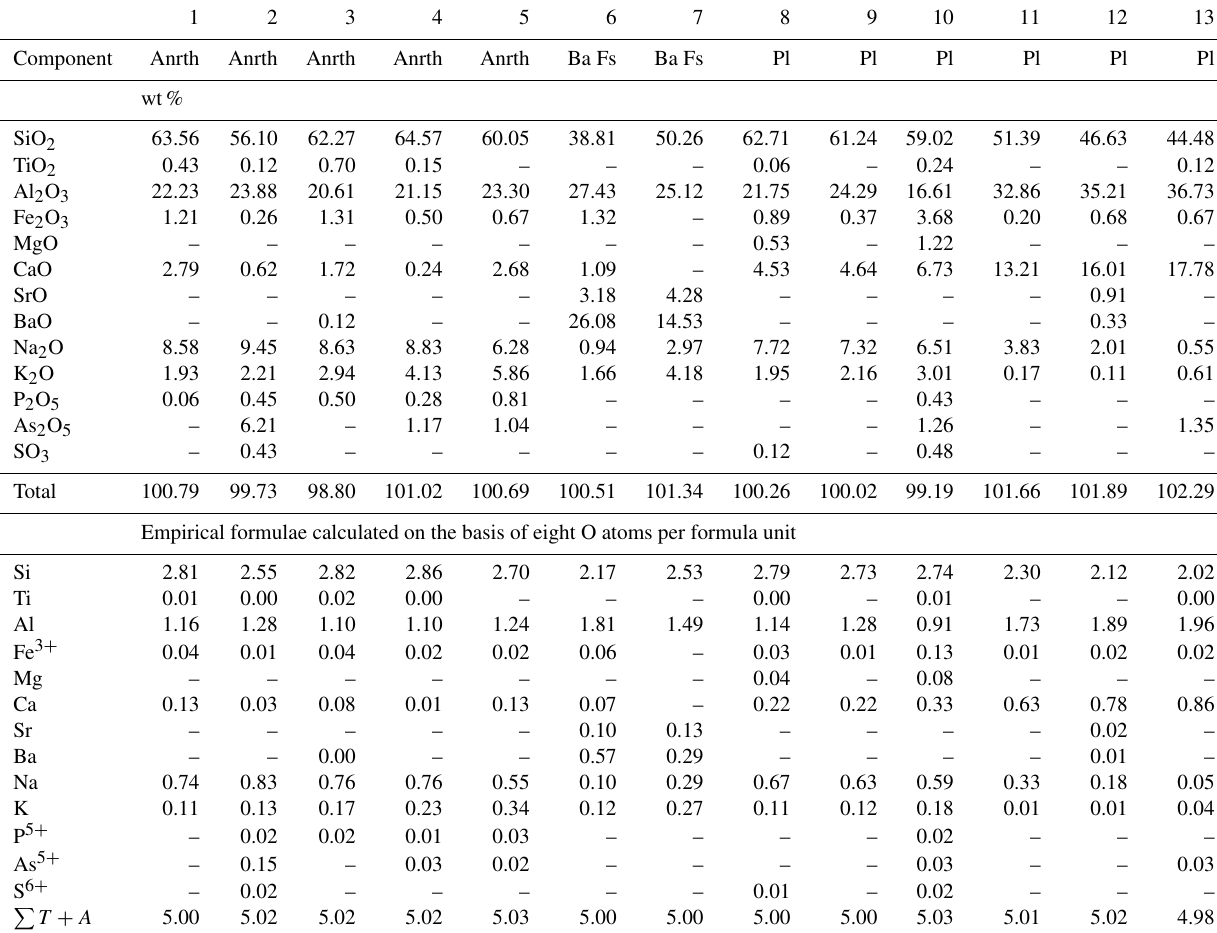
Table 3. Chemical composition of anorthoclase (Anrth), barium feldspar (Ba Fs) and plagioclases (Pl) from the Arsenatnaya